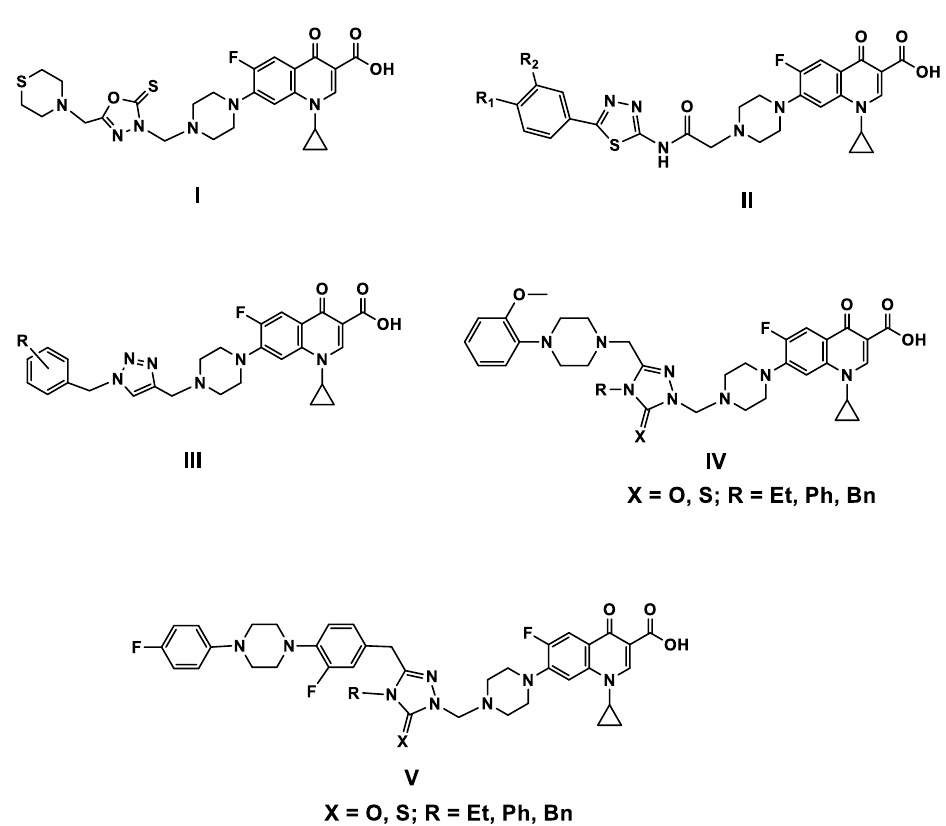
Figure 2. Chemical structures of some ciprofloxacin-azole hybrids I–V . Continuing our quest to find a compound with improved antimicrobial properties [20–27], the current study describes the synthesis and structure elucidation of Fluoroquin- olone(ciprofloxacin)-based hybrids containing various heterocycle derivatives, as well as antimicrobial activity evaluation using various strains of Gram-positive ( S. aureus and B. subtilis ), Gram-negative ( E. coli and P. aeruginosa ), and fungi ( A. flavus and C. albicans ). In addition, the inhibitory activity of the most active compounds against E. coli DNA gyrase and topoisomerase IV has been identified as a potential molecular target.